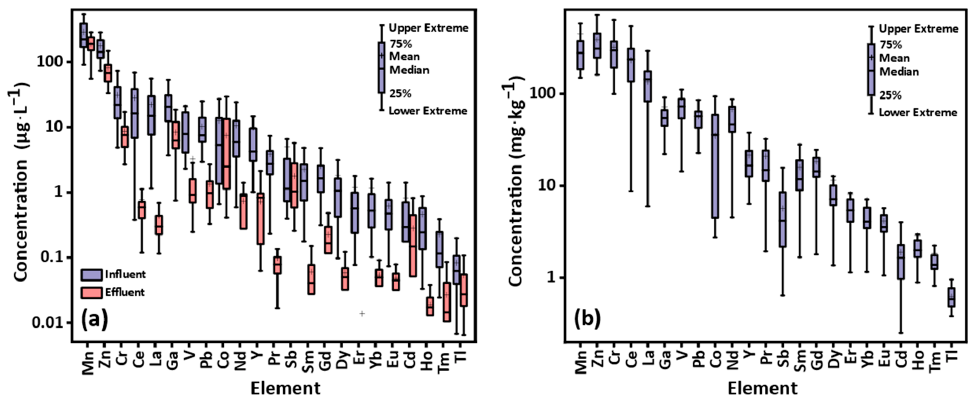
Figure 1. Element concentrations in influent and effluent ( a ) and in sludge ( b ) at 7 WWTPs (box plots show the upper extreme, lower extreme, 25th and 75th percentile, mean and median values).